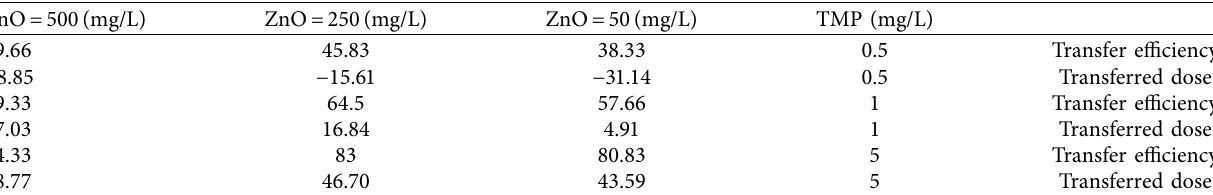
Table 3: The transfer efficiency of ozone and transferred dose.